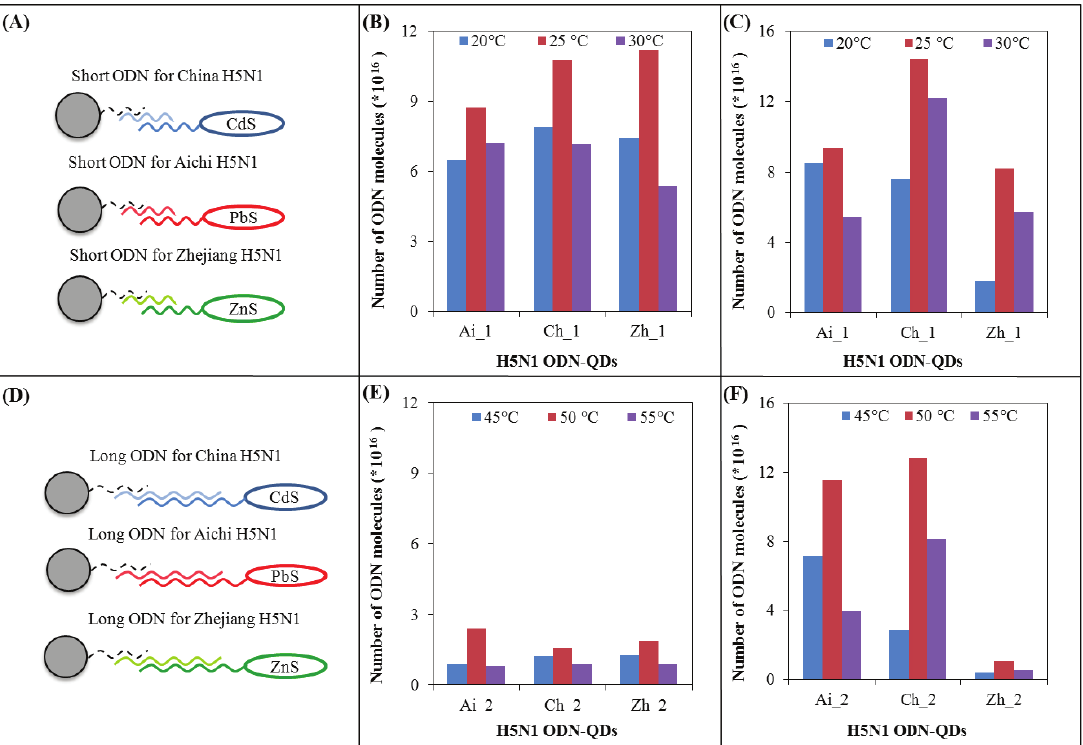
Figure 5. The effect of different temperatures on hybridization of short and long ODN-QDs derived from H5N1 gene for neuraminidase. ( A ) Short and/or ( D ) long ODN anti-sense (anti-H5N1 Zhejiang, China and Aichi) modified MPs with covalently bound were used as a tool for isolation of complementary H5N1 strands (H5N1 oligo(dT) 25 Zhejin, China and Aichi) labeled with QDs (CdS, ZnS and/or PbS). ( B + C ) The effect of the temperature of hybridization (20, 25 and 30 °C) on number of hybridized molecules of short ODN-QDs abbreviated as Ai 1, Ch 1 and Zh 1; ( B ) Number of H5N1 molecules was calculated from the height of CA peak; ( C ) Number of H5N1 molecules was calculated from the height of metal peak. ( E + F ) The effect of the temperature of hybridization (45 °C, 50 °C and 55 °C) on number of hybridized molecules of long ODN-QDs abbreviated as Ai 2, Ch 2 and Zh 2; ( E ) Number of H5N1 molecules was calculated from the height of CA peak; ( F ) Number of H5N1 molecules was calculated from the height of metal peak. AdTS SWV method was used to measure the height of CA peak was used (parameters are in caption in Figure 3). DPASV method was used to measure the height of metal peak (parameters are in caption in Figure 3). Blue color: minimal temperature of hybridization was 20 °C for 12 nucleotides long ODNs and/or 45 °C for 28 nucleotides long ODNs, red color: optimal temperature of hybridization was 25 °C for 12 nucleotides long ODNs and/or 50 °C for 28 nucleotides long ODNs, violet color: minimal temperature of hybridization was 30 °C for 12 nucleotides long ODNs and/or 55 °C for 28 nucleotides long